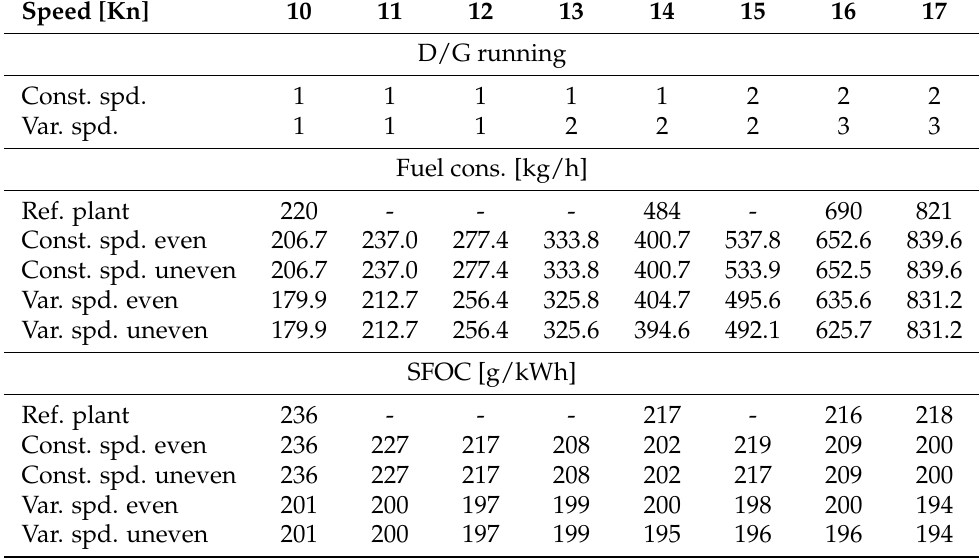
Table 6. Quantitative performance